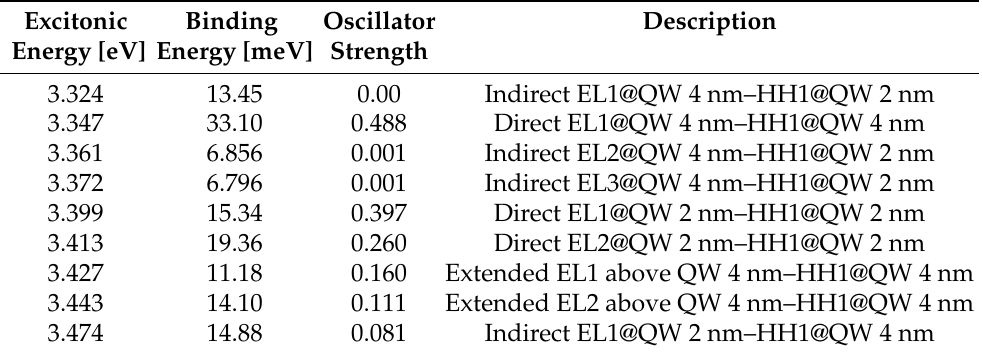
Table 6. Calculated excitonic and binding energy, oscillator strength within 8 k·p self-consistent excitonic model for various type of excitons observed in the structure